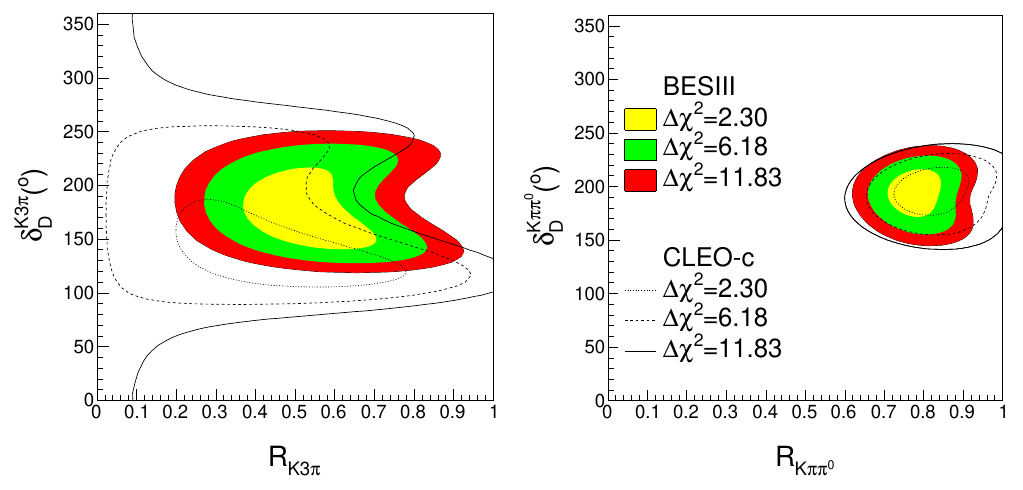
) and ( R , δ Kππ 0 ) parameter space, Kππ 0 D D